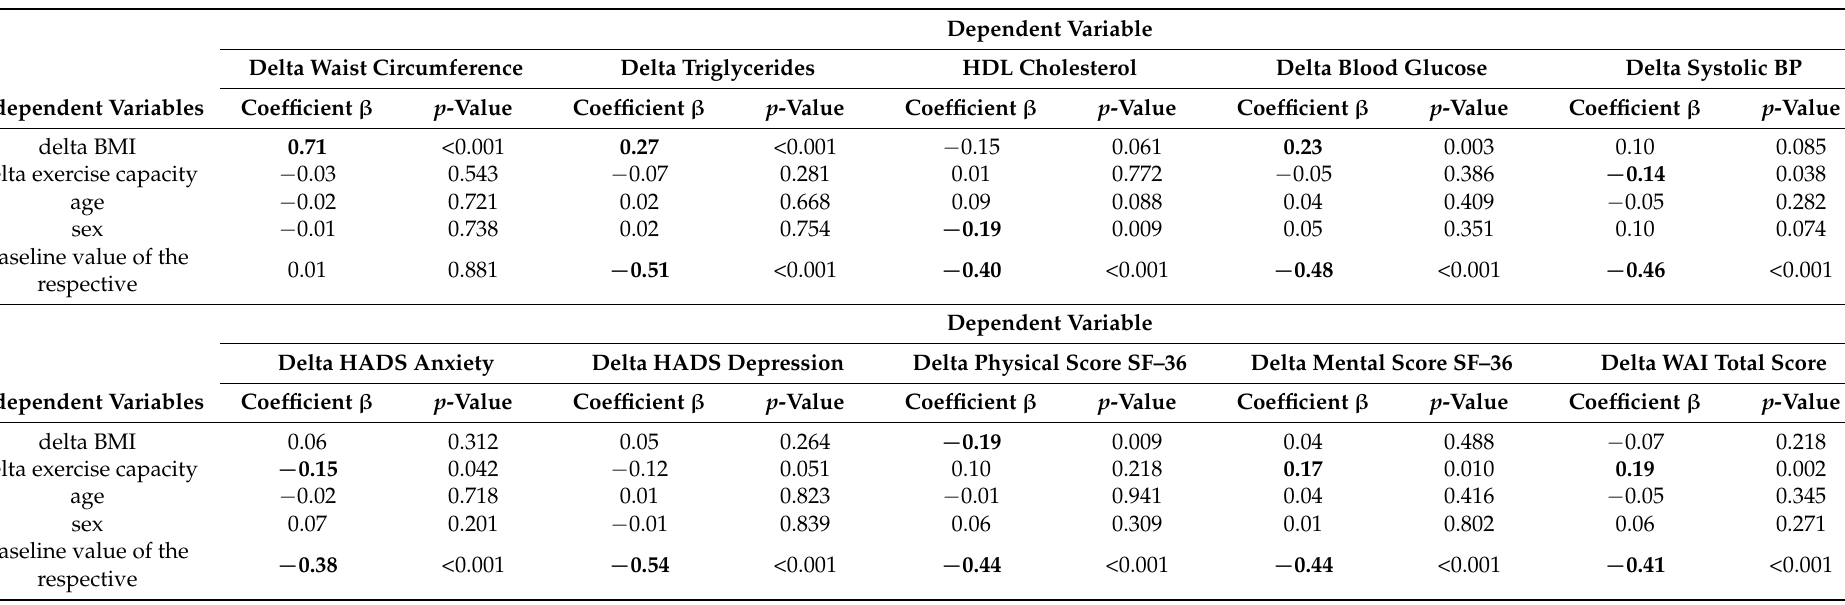
Table 3. Multivariable Regression Analyses between 6–month Intervention-induced Changes in MetS Components and Components of